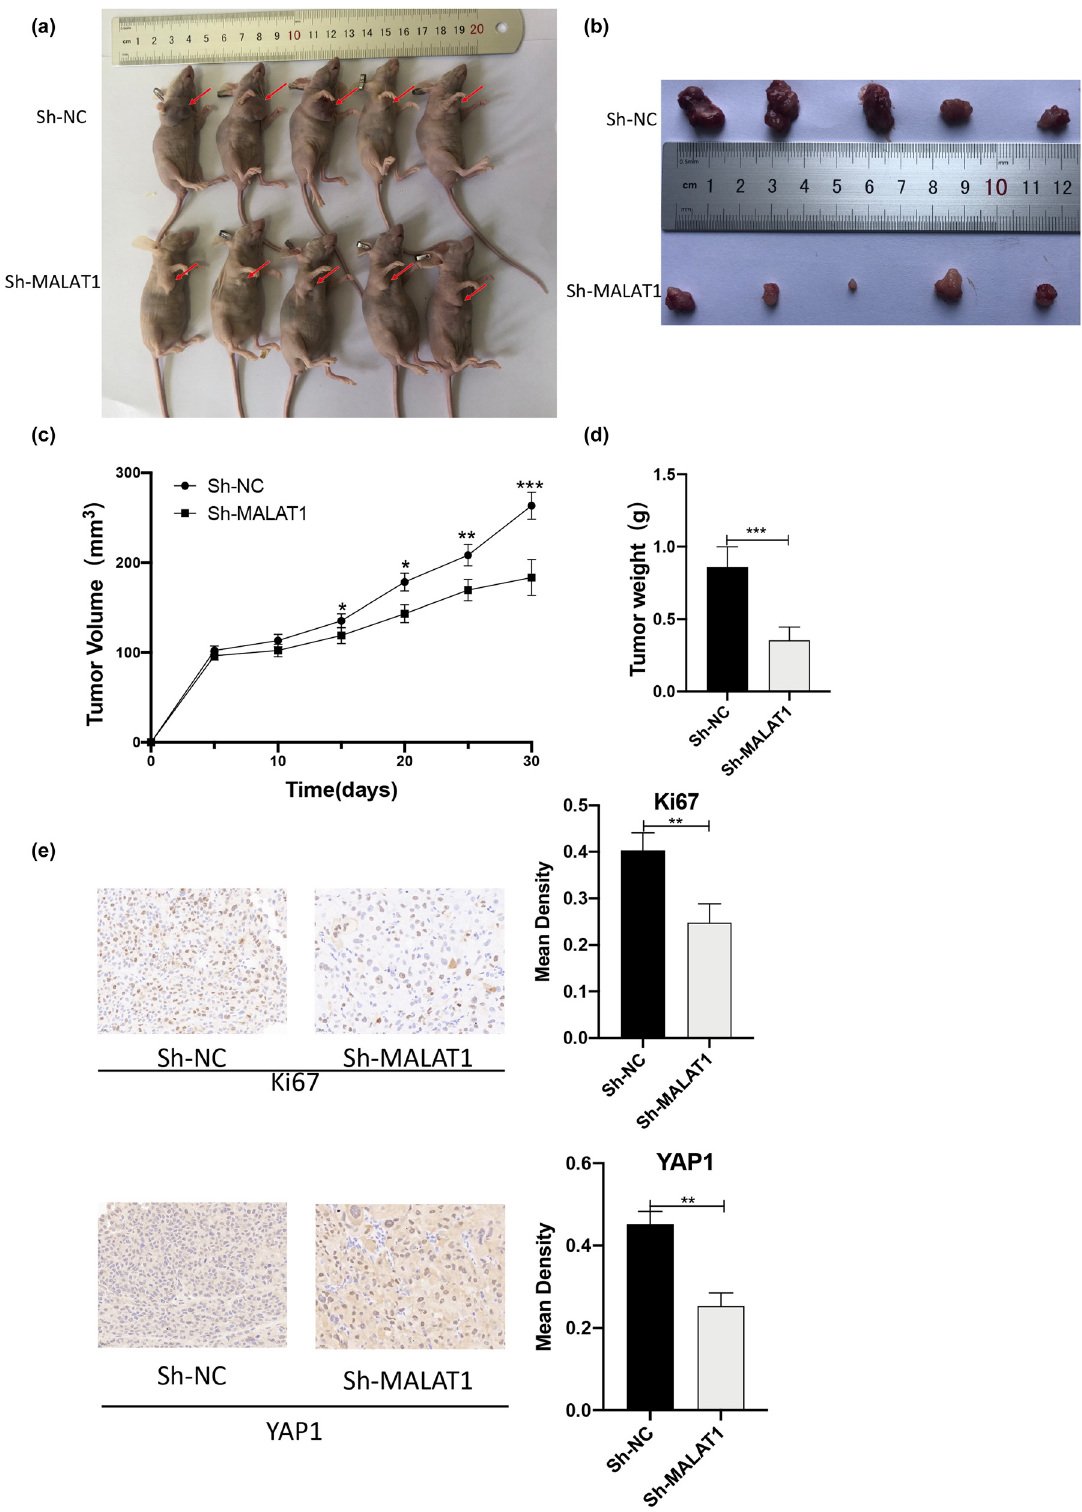
Figure 2: Knockdown of MALAT1 inhibits the growth of MPM cells in vivo . ( a and b ) sh - MALAT1 inhibits the growth of MPM cells in xenograft mice. It can be seen that the subcutaneous transplanted tumor is located in the right axilla of nude mice, and the volume of Sh - MALAT1 group is signi fi cantly smaller than that of Sh - NC group. ( c and d ) sh - MALAT1 inhibits volume and weight of MPM tumor ( n = 5 per group, * P < 0.05, ** P < 0.01, *** P < 0.001, t - test ) . ( e ) IHC staining showed that the expressions of Ki67 and YAP1 were reduced in xenograft tumor tissues of mice that received sh - MALAT1 - transfected H226 cells ( ** P < 0.01, t - test )